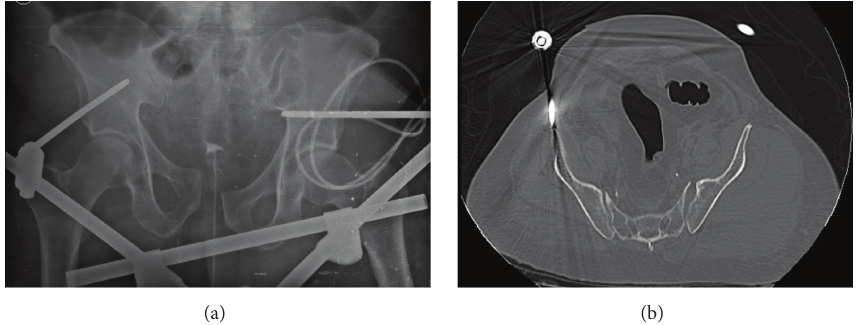
Figure 2: (a) Anteroposterior radiograph of the pelvis showing pubic symphysis diastasis. (b) CT scan axial view confirms pelvic ring injury due to sacroiliac joint subluxation without bone involvement.